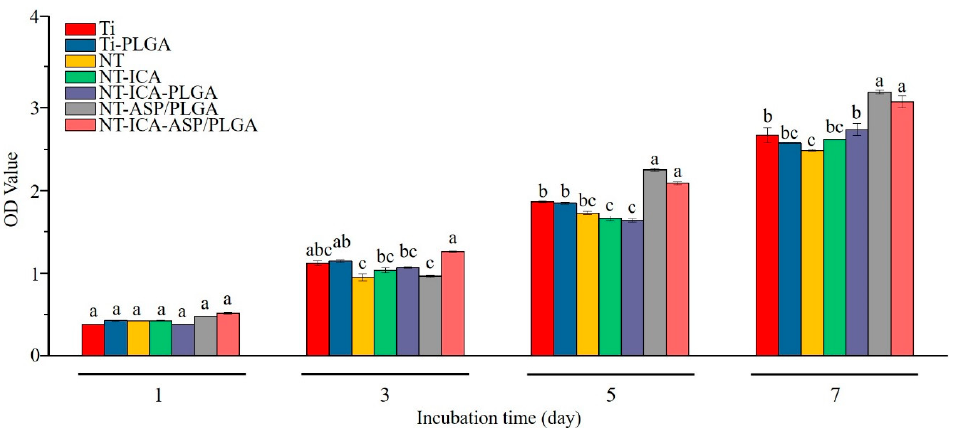
Figure 9. The CCK-8 results of MC3T3 − E1 cells cultured on different surfaces for 1, 3, 5 and 7 days. Different lowercase letters indicate statistically significant differences between different groups ( p < 0.05). Data are mean ± SD, n = 3 replicates each group.